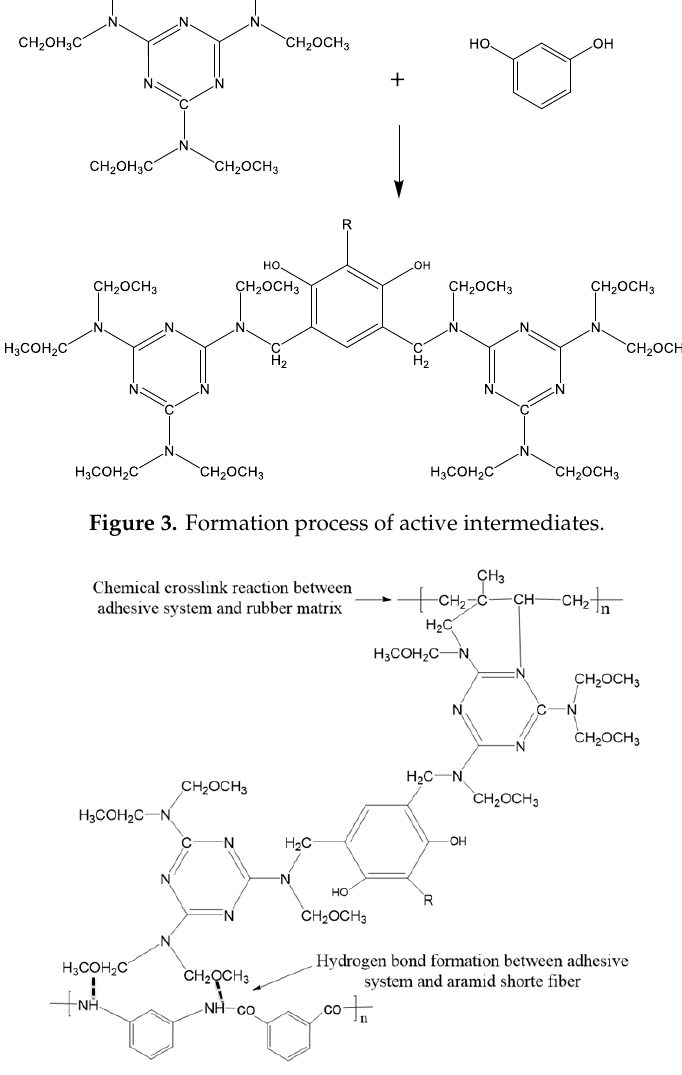
Figure 4. Adhesion process between short fiber and rubber matrix.